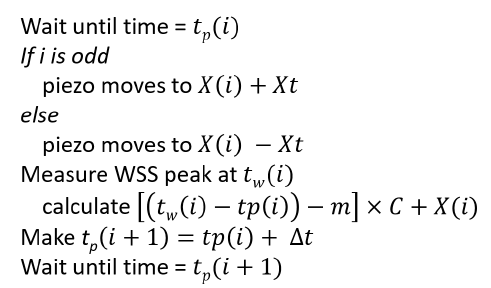
Figure 4. The algorithm applied in the SMR with the piezo stage.